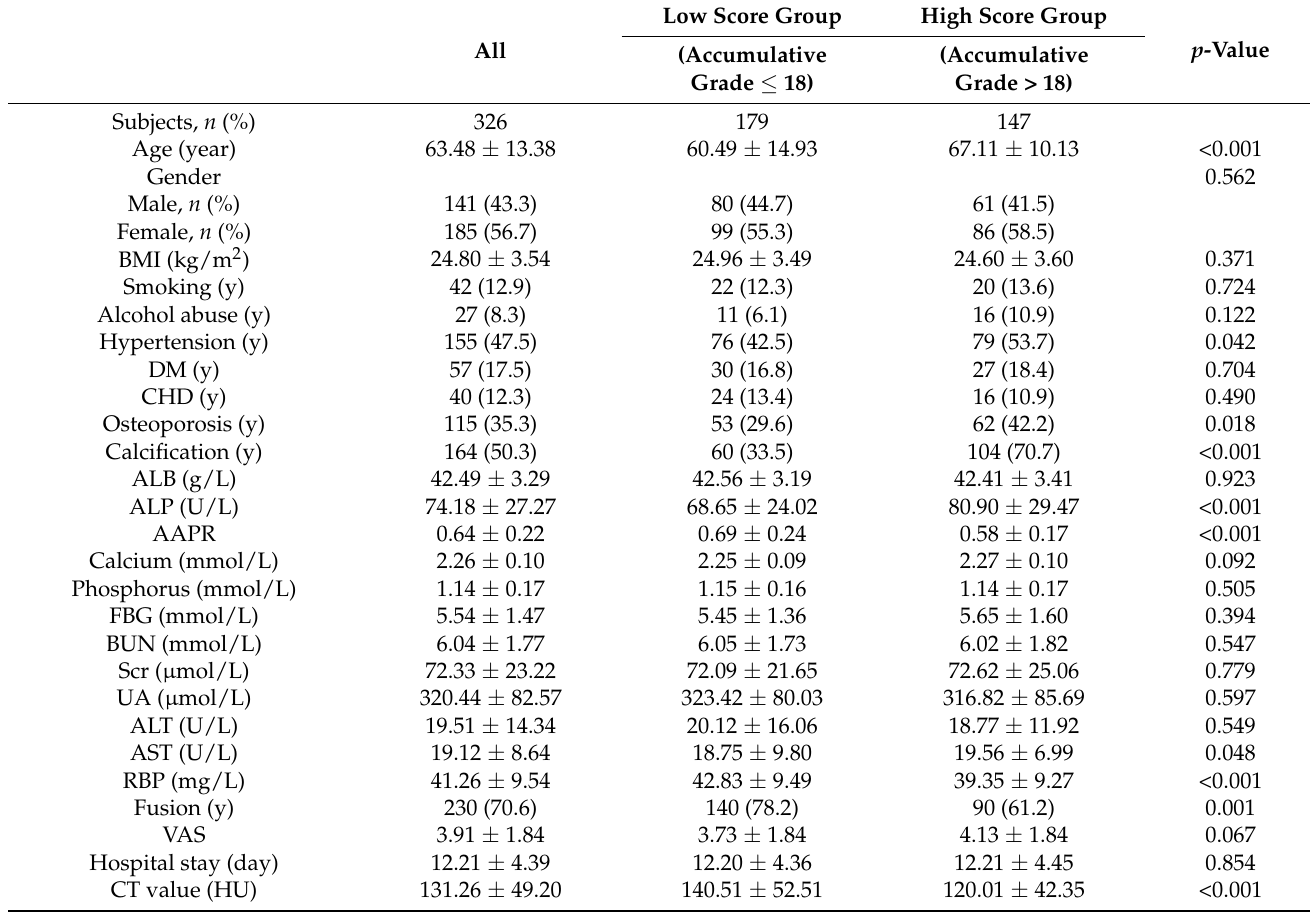
Table 1. Demographic characteristics of patients with disc degeneration